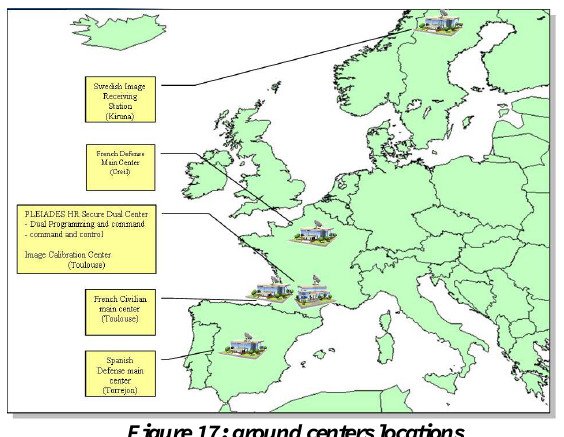
Figure 17: ground centers